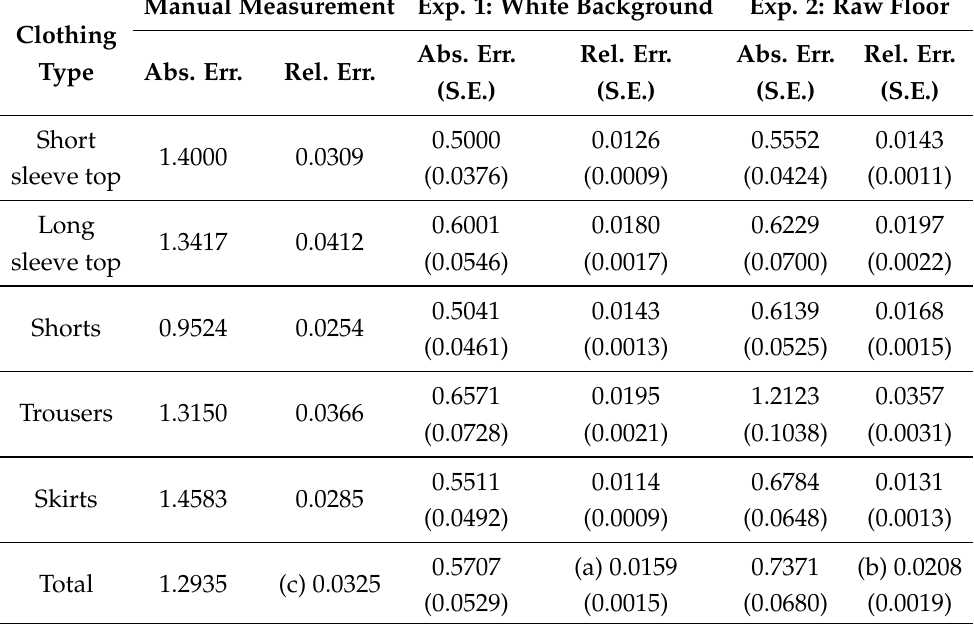
Table 2. Experimental results. ’Abs. Err.’, ’Rel. Err.’, and ’S.E’ are abbreviations for absolute error, relative error, and standard error, respectively. In experiments 1 and 2, the relative errors were (a) 1.59% and (b) 2.08%, respectively, lower than the (c) 3.25% of the manual measurement. Manual Measurement Exp. 1: White Background Exp. 2: Raw